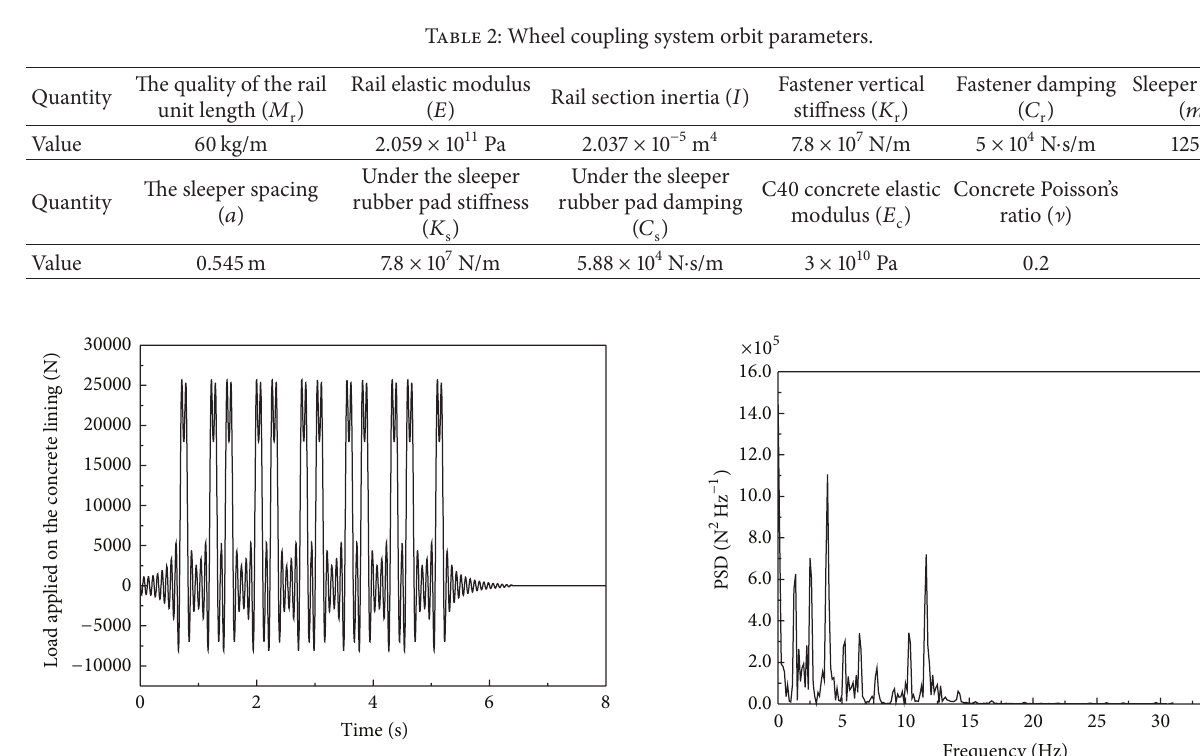
Figure 6: Vertical load applied on the tunnel shell.